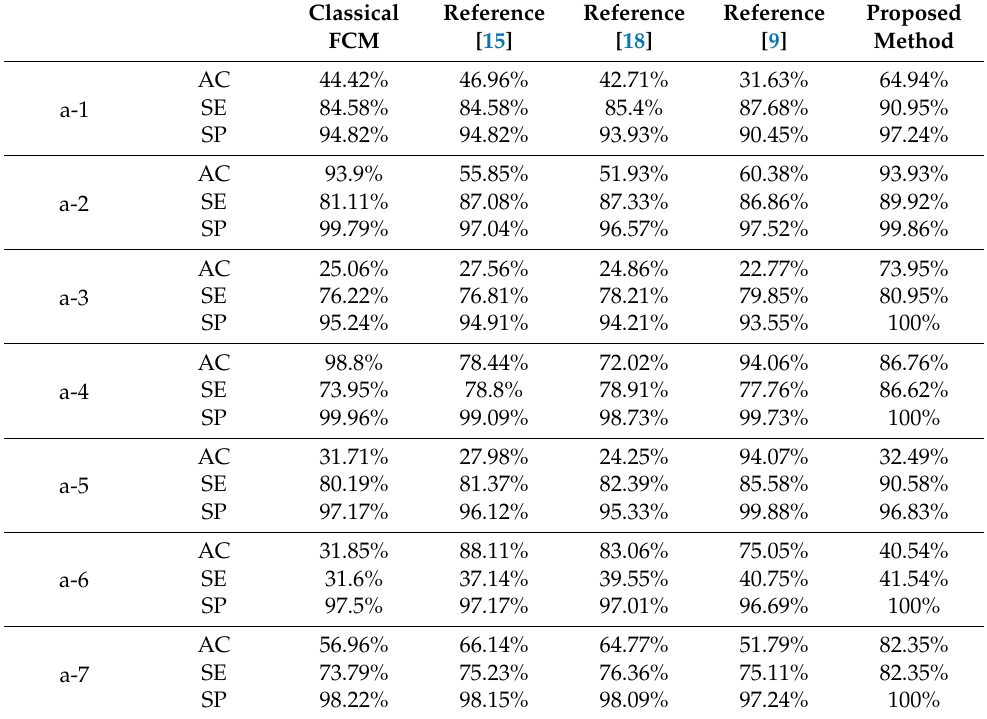
Table 6. Performance comparison of different algorithms.